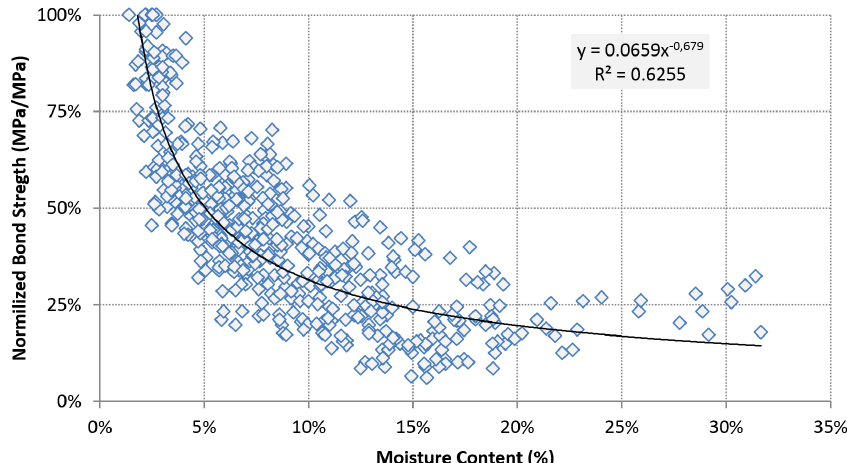
Figure 8. Normalized bond strength results versus moisture content. Bond strength equal to 1 corresponds to the minimum measured moisture